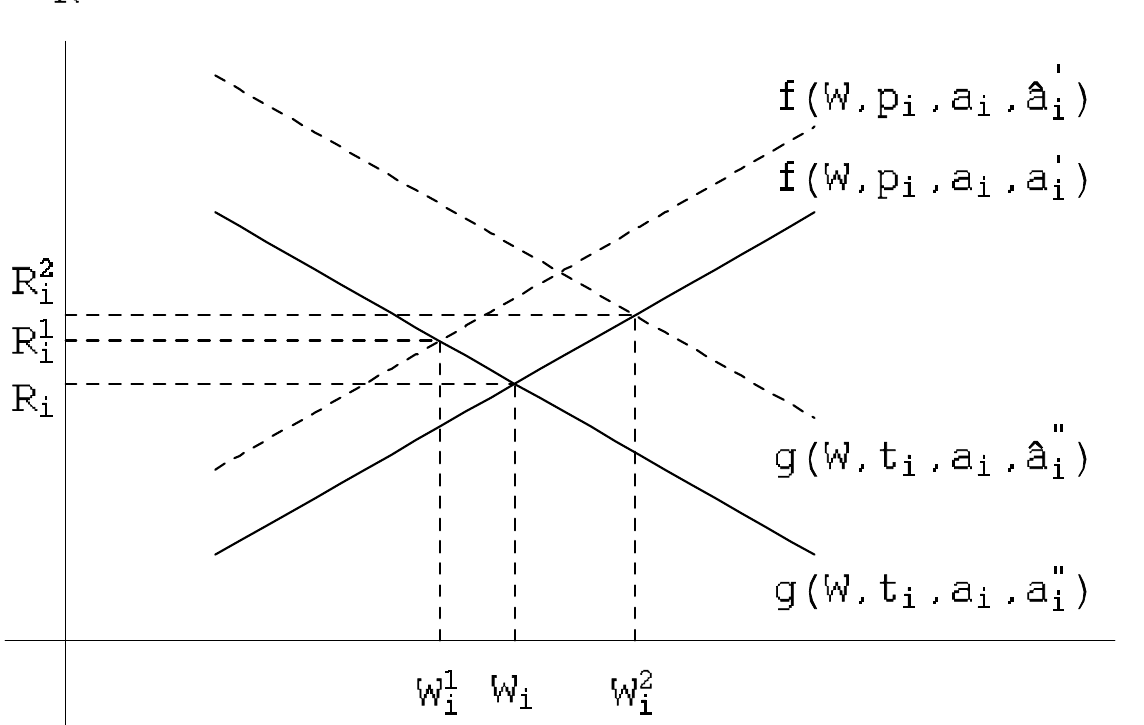
Figure 1. Determination of equilibrium.